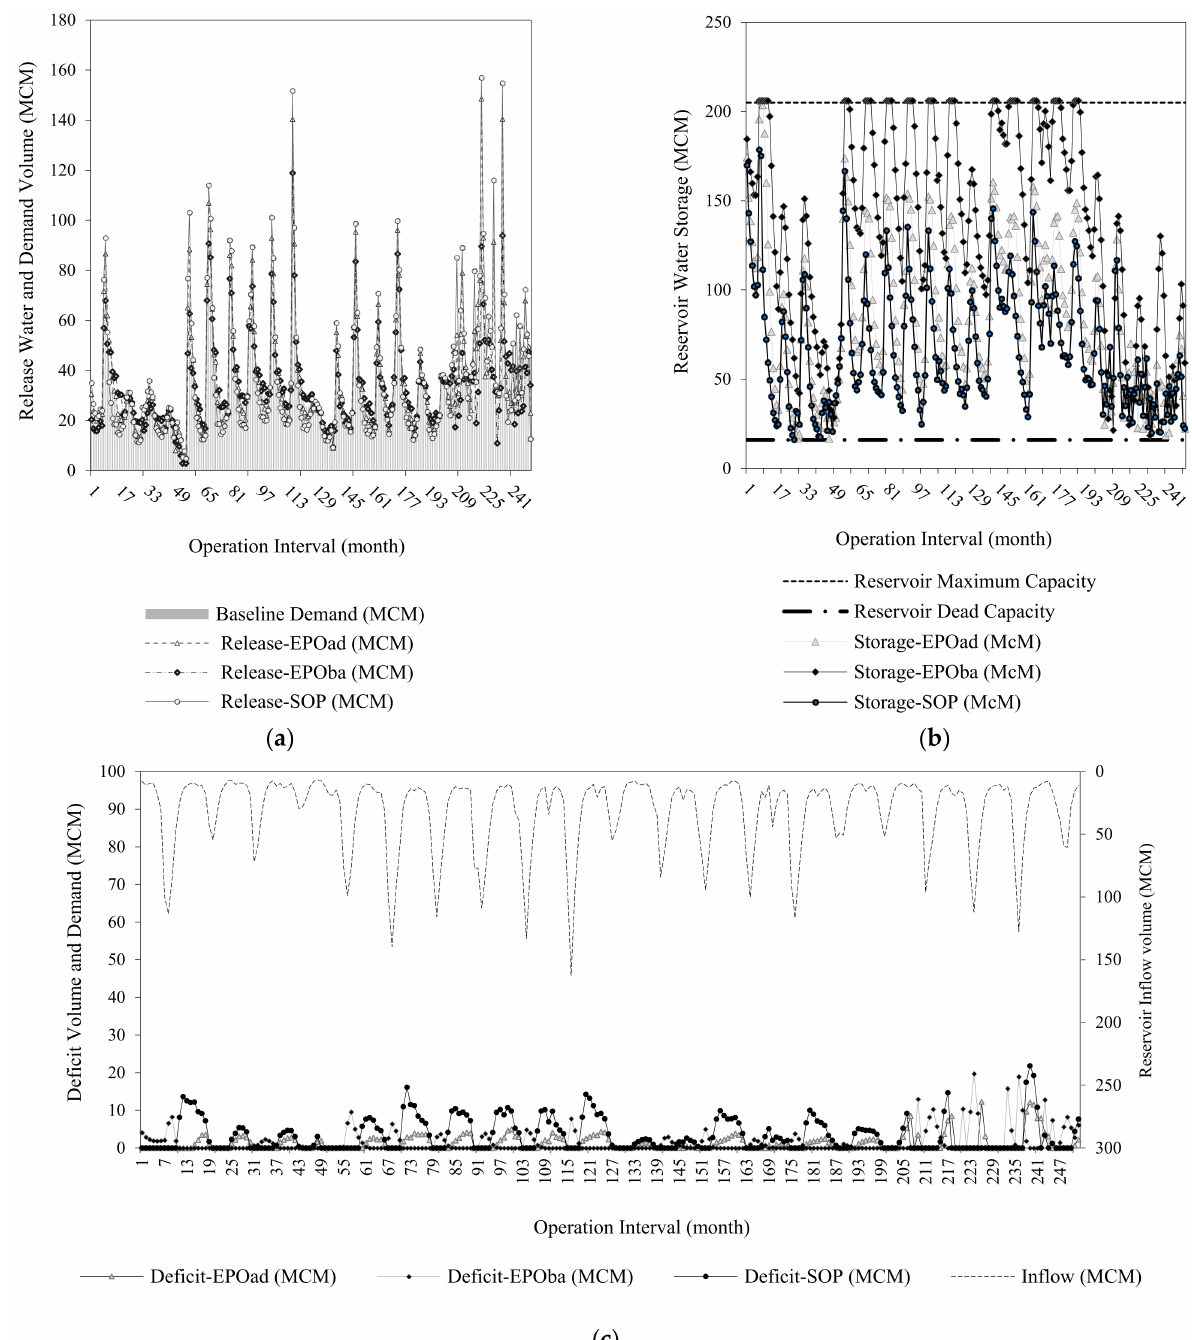
Figure 6. Change in output, storage, deficit volume using EPO ad and EPO ba algorithms in the first and second scenarios: ( a ) Released water and demand Volume (MCM); ( b ) Reservoir storage (MCM); ( c ) Deficit, demand and reservoir inflow volumes